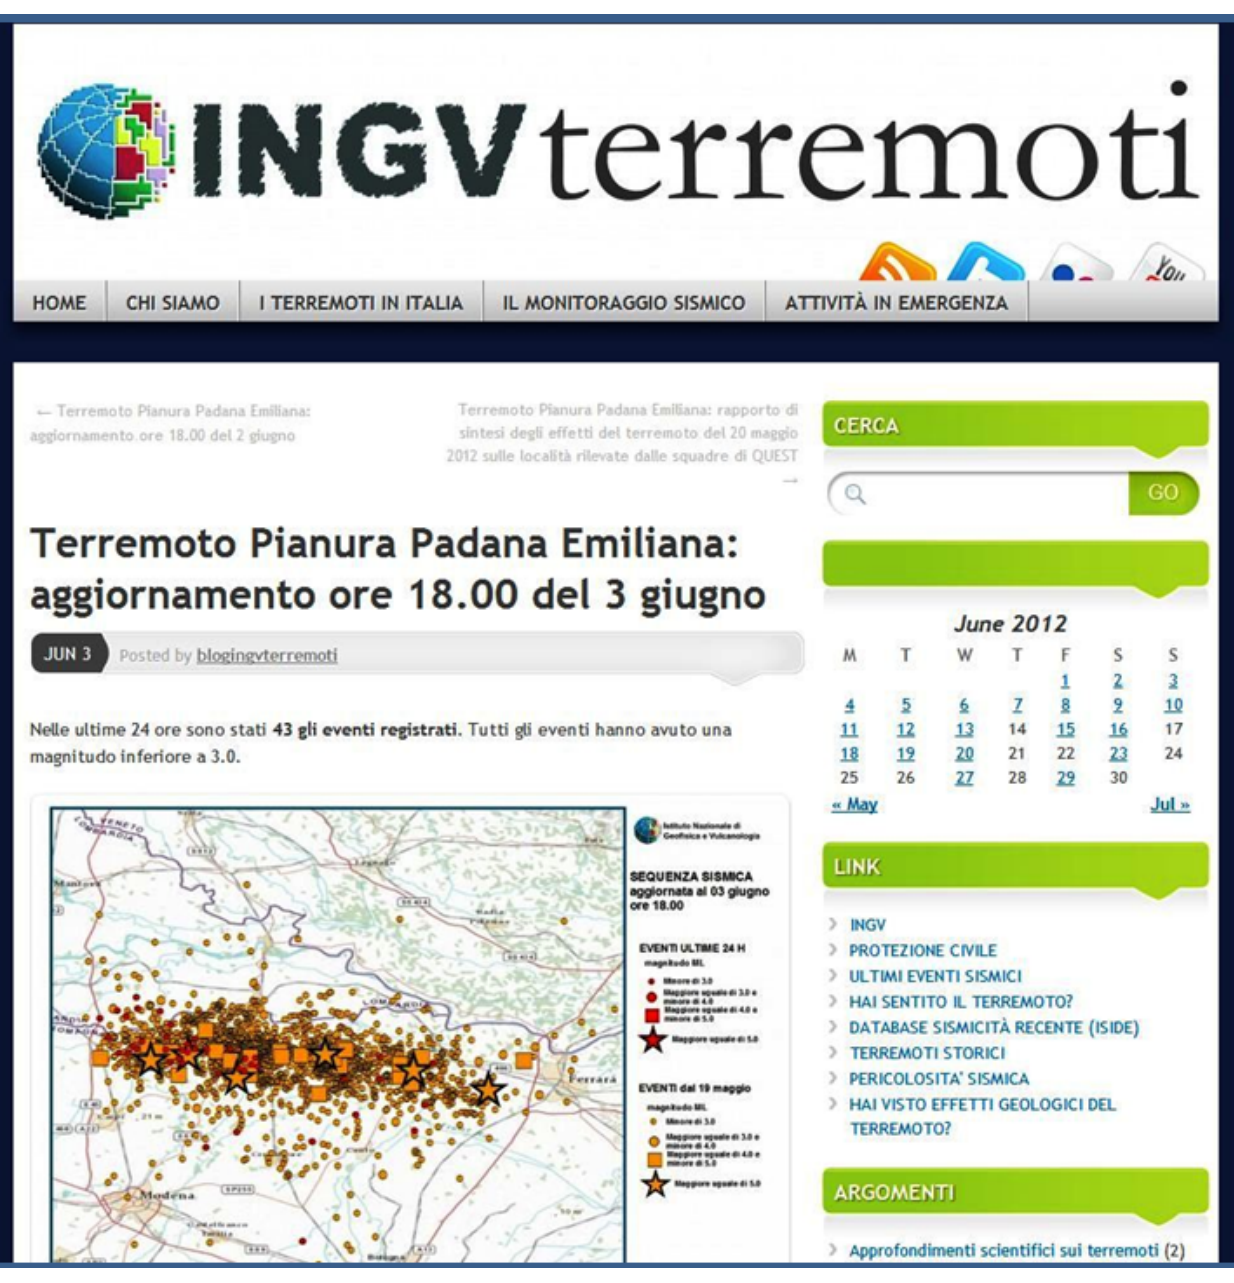
Figure 1. The top part of the INGVterremoti blog as it appeared on June 3, 2012, soon after the most clicked update was posted (857,785